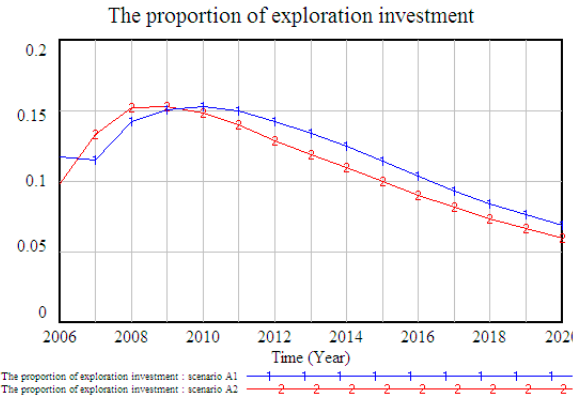
Figure 5. The proportion of exploration investment.